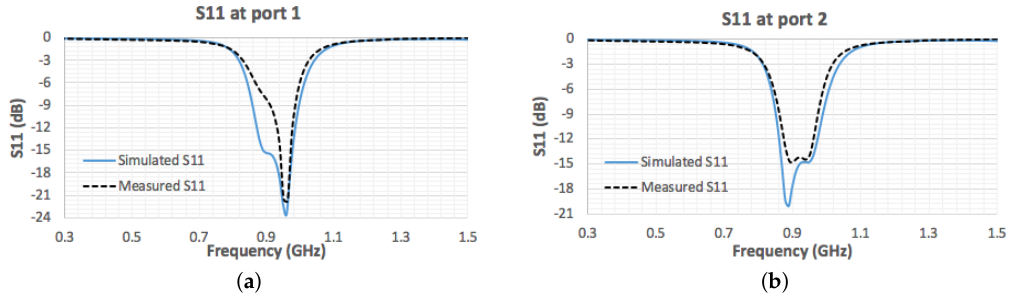
Figure 12. Simulated and measured reflection coefficients at: ( a ) Port 1 and ( b ) Port 2.